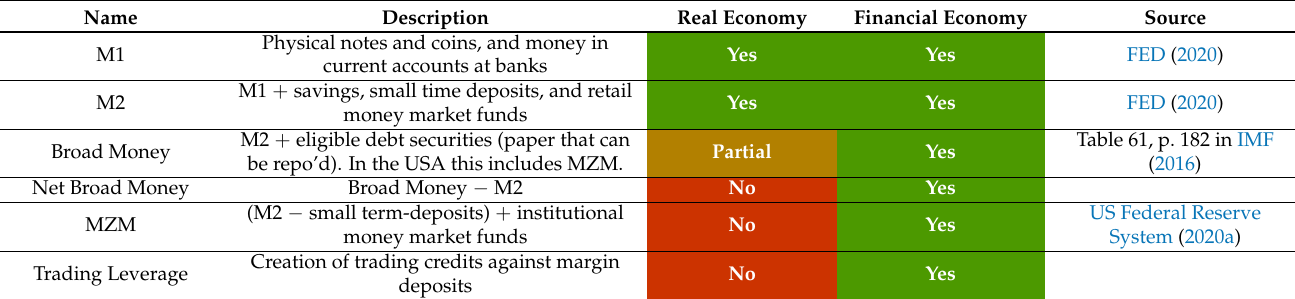
Table 5. Components of the monetary